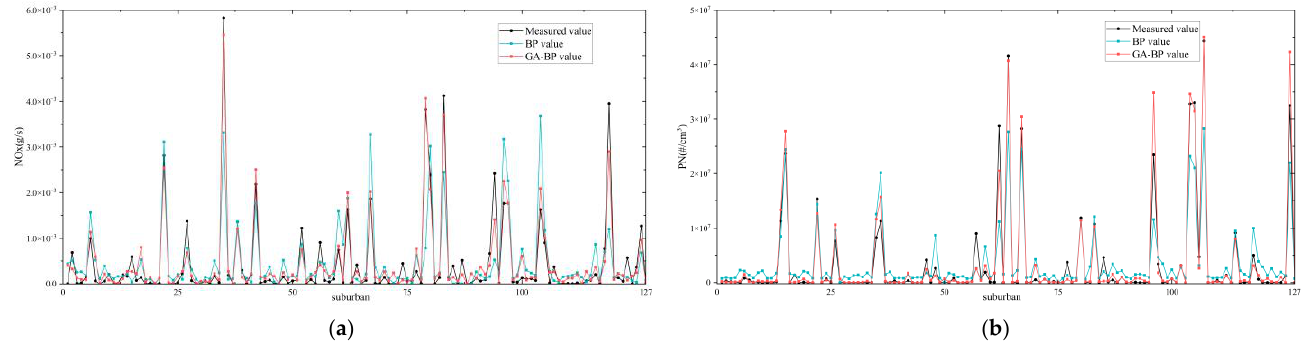
Figure 9. Comparison of the predicted results of BP and GA-BP for NOx and PN in suburban areas with the measured values. ( a ) Suburban NOx; ( b ) suburban PN.